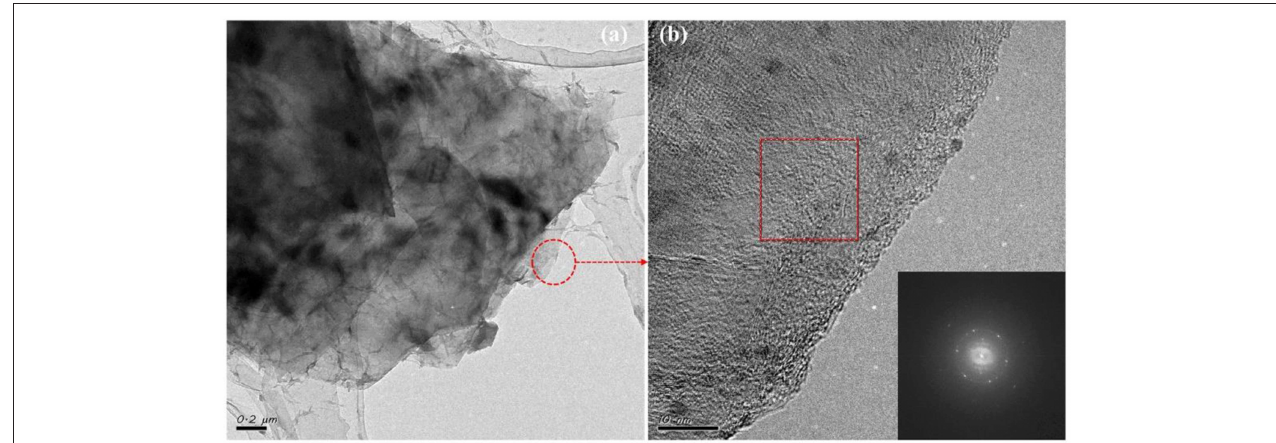
FIGURE 2 | The TEM (a) and HRTEM (b) images of graphene, the inset is fast fourier transform (FFT) image.